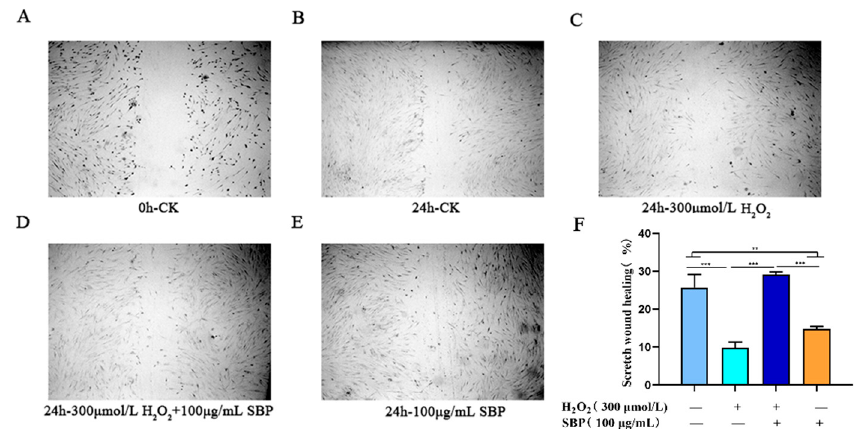
Figure 6. Effect of SBP on H 2 O 2 -induced senescent HSFs’ cell migration. ( A ): Microscopic observation of the blank control group at an incubation time of 0 h. ( B ): Microscopic observation of the blank control group at an incubation time of 24 h. ( C ): Microscopic observation of cells cultured for 24 h after adding 300 µ moL/L H 2 O 2 to the culture medium. ( D ): Microscopic observation of cells cultured for 24 h after adding 300 µ moL/L H 2 O 2 and 100 µ g/mL to the culture medium. ( E ): Microscopic observation of cells cultured for 24 h after adding 100 µg/mL to the culture medium. ( F ): Cell migration rate of different experimental treatment groups after 24 h of cultivation. In the figure " + " means added, " − " means not added. The results are the mean ± SD of three independent experiments. ** p < 0.01, and *** p < 0.001 indicate significant differences compared with the various experimental groups.